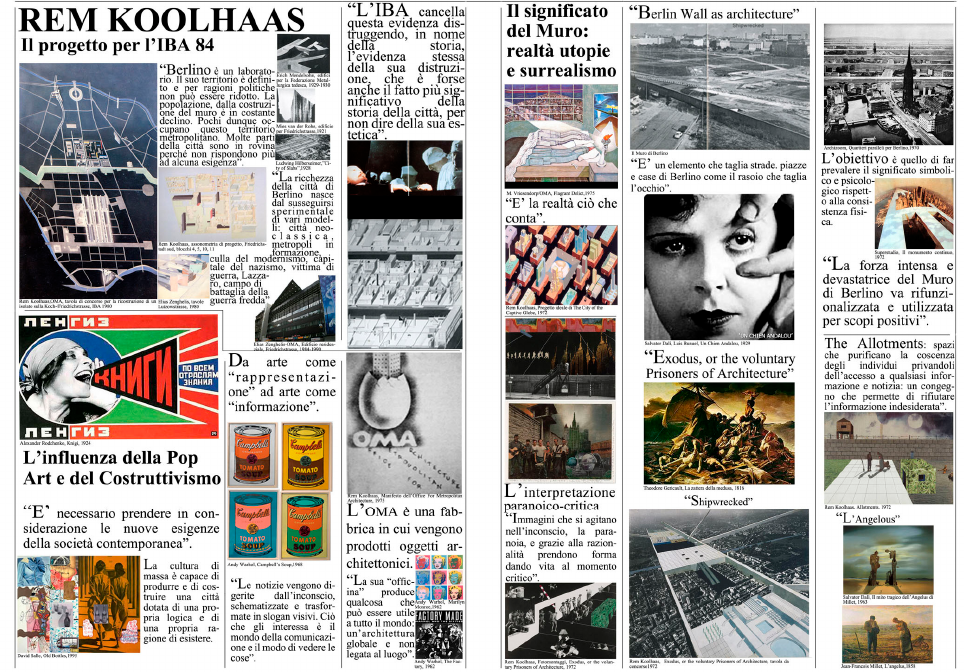
Figure 8. Giulia Bertola, Synthetic interpretative collage of Koolhaas’s competition entry for IBA